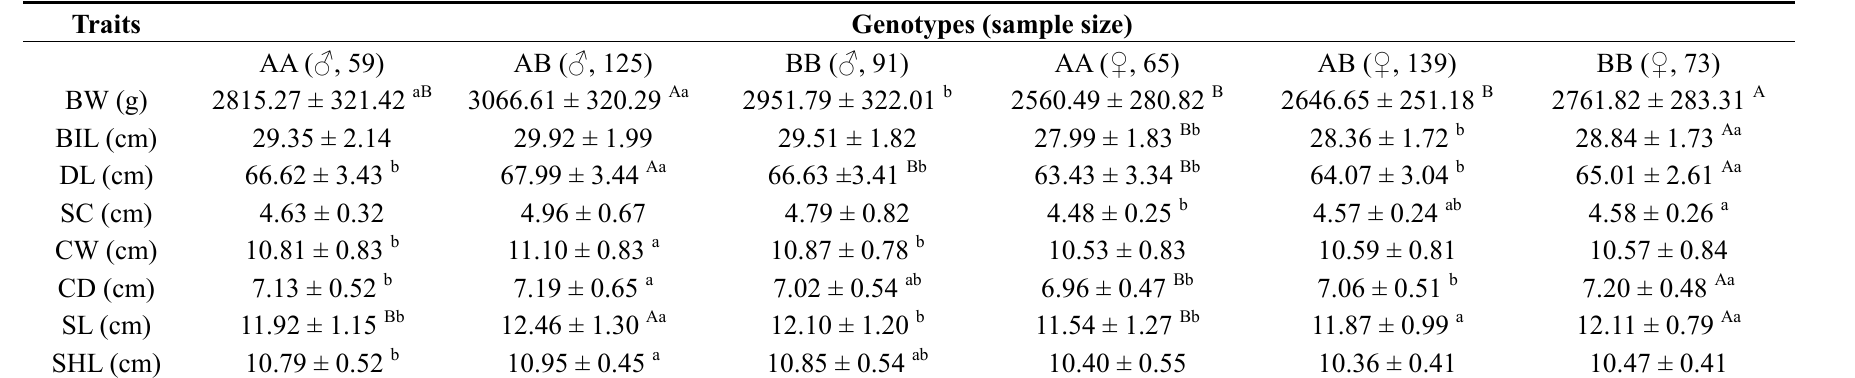
Table 2. Body weight and other body traits of genotypes of exon 2 of the GH gene. BW, body weight; BIL, inclined body length; DL, dive length; SC, shank circumference; CW, chest width; CD, chest depth; SL, sternum length; SHL, shank length. Data represent the least-squares mean ± SD. a,b Means with different superscripts are significantly different ( p < 0.05). A,B Means with different superscripts are significantly different ( p < 0.01). ♂ , male population; ♀ , female population.